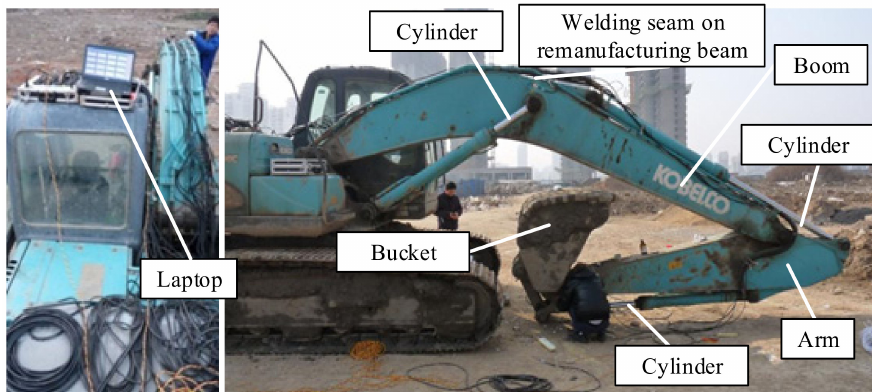
Figure 9. The cylinder stress and displacement test